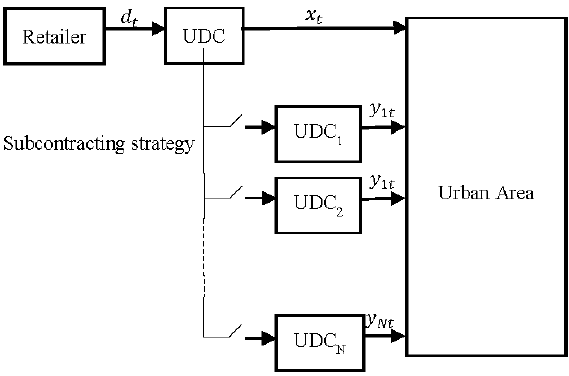
Figure 1. Problem description; UDC (urban distribution center).